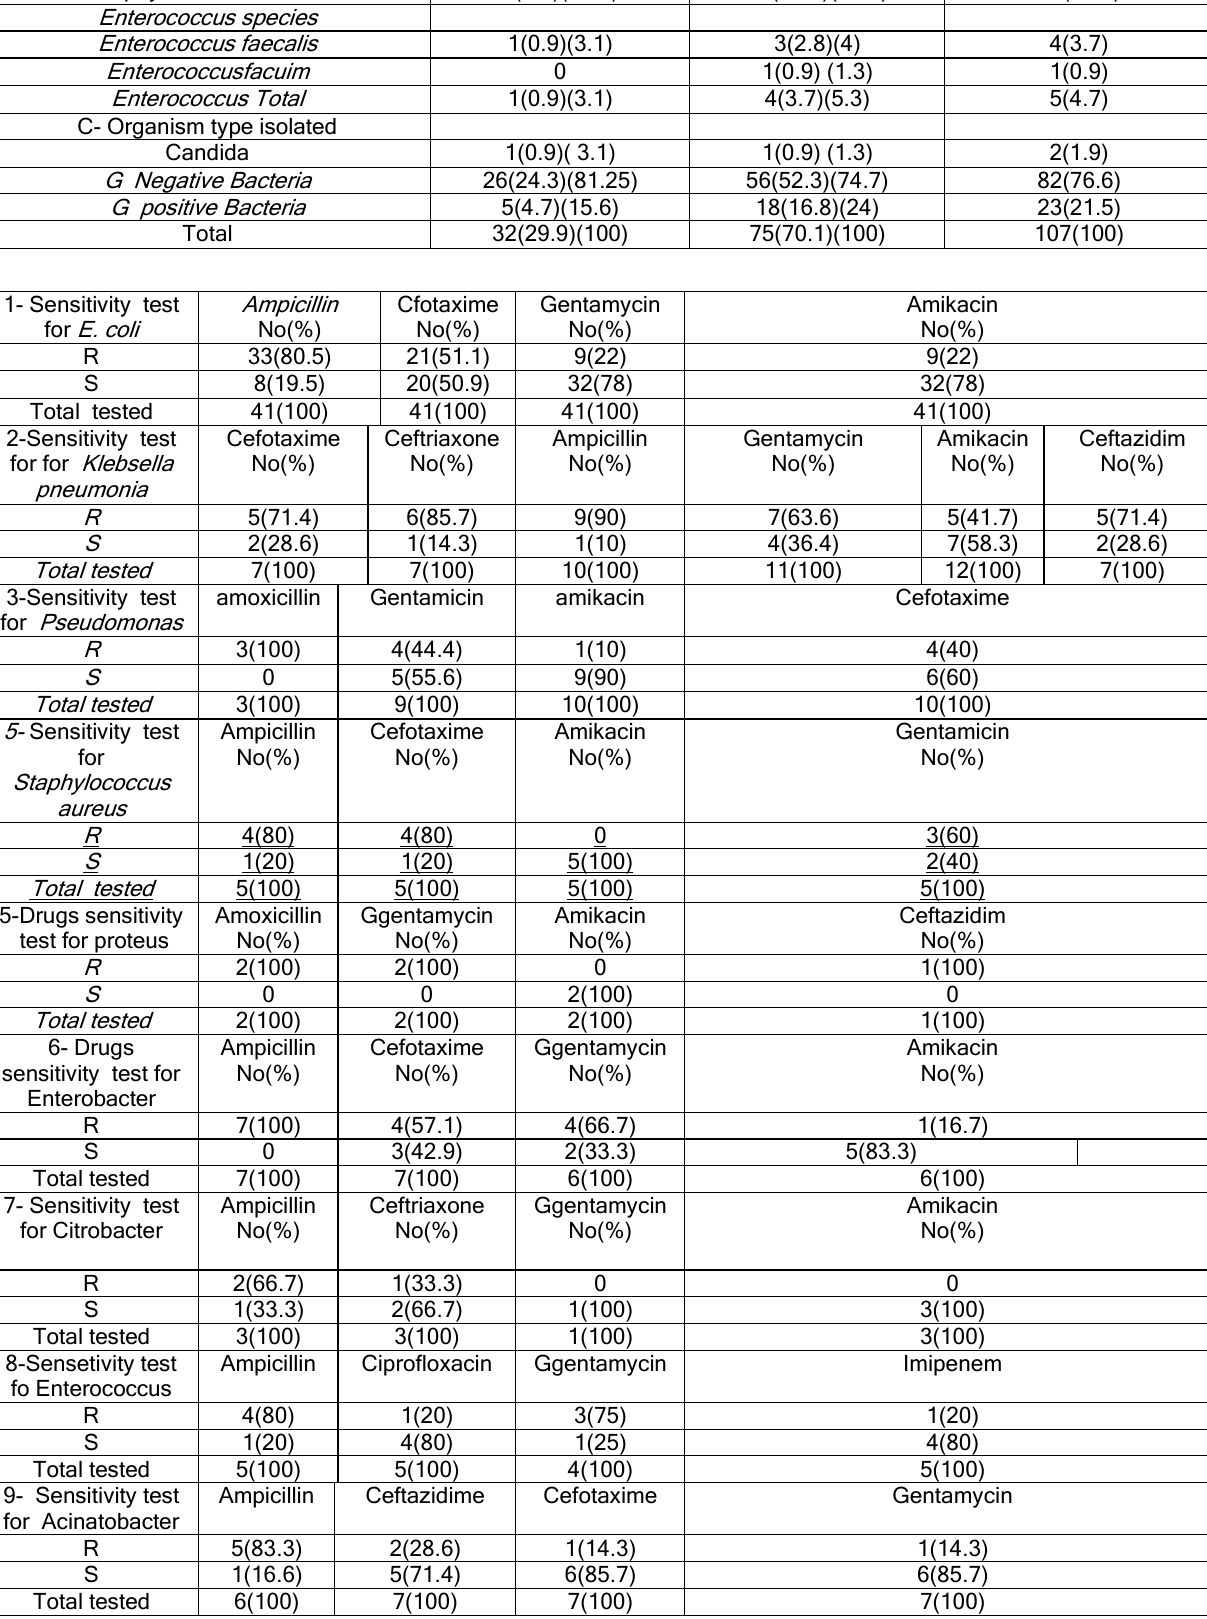
Table 2 Bacterial sensitivity